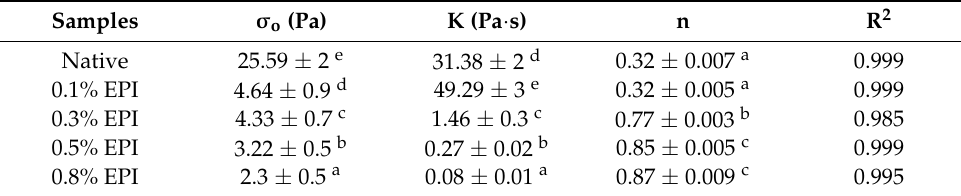
Table 4. Steady shear characteristics of native and modified starches.